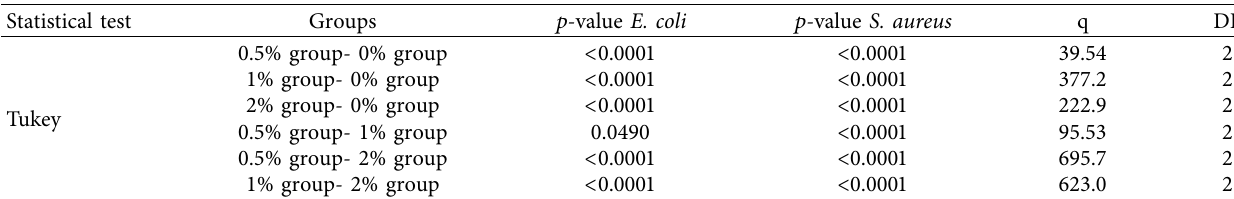
Table 2: Results for Tukey’s post hoc of antimicrobial test between the groups (0.5%, 1%, and 2%) and 0% group in both bacteria. Statistical test